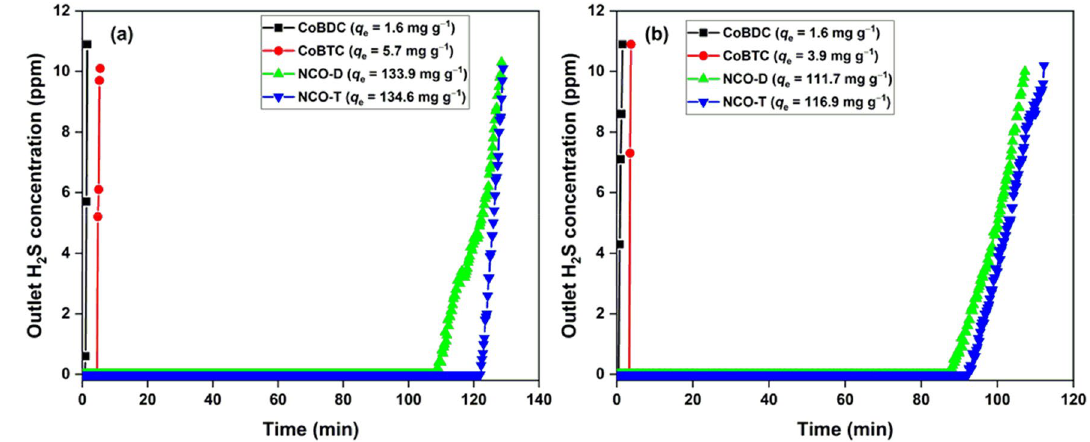
Figure 4. H 2 S breakthrough curves of MOFs and derived metal oxides in ( a ) dry; ( b ) moist conditions. [Adsorbent] = 0.2 g, flowrate = 0.3 L min −1